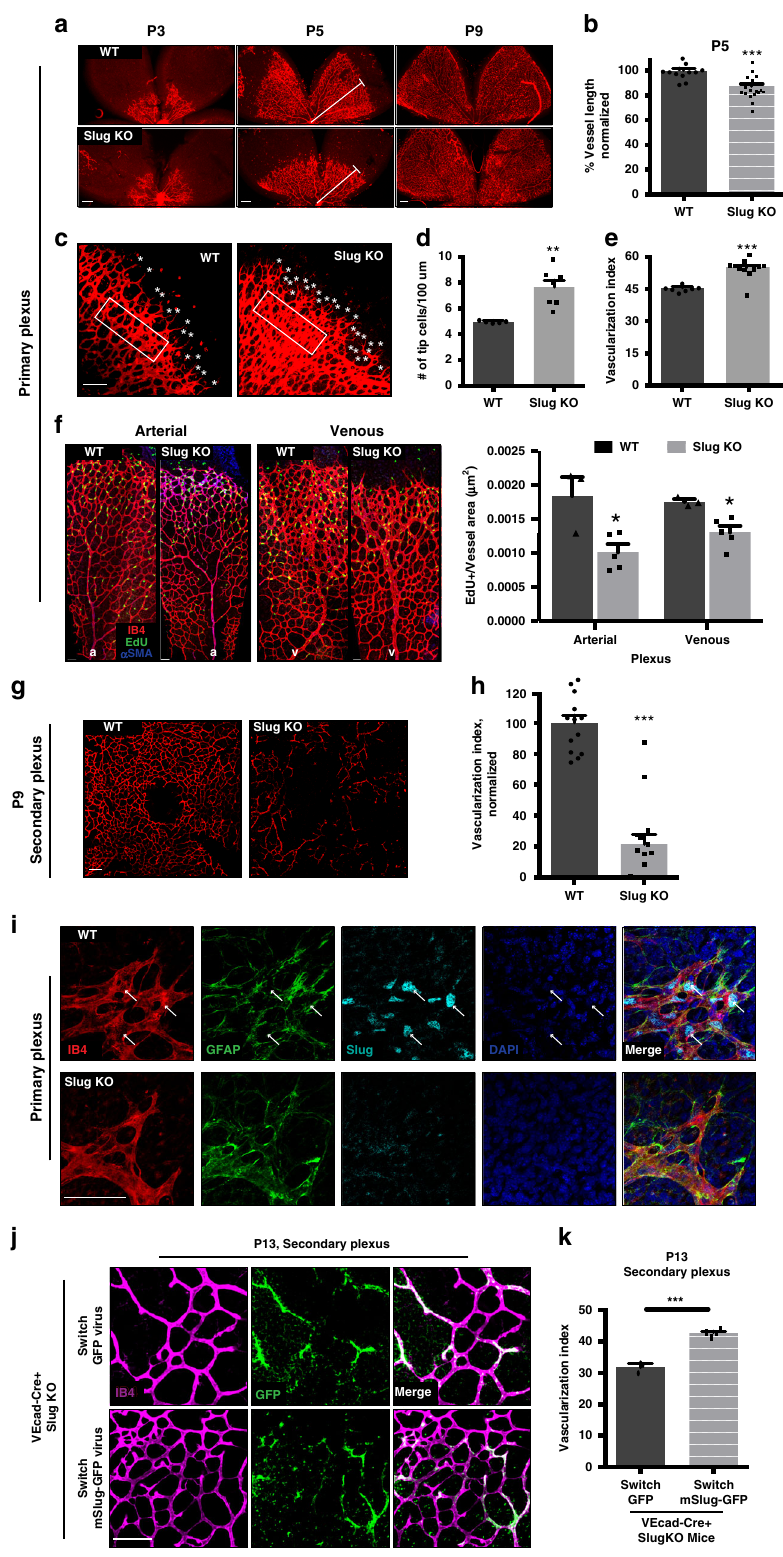
human EC migration in vitro 19 . In SlugKO mice, however, this defect was transient, and became less obvious by postnatal day 9 (P9; Fig. 2a and Supplementary Fig. 4a). Further examination of P5 SlugKO retinas revealed an increase in both tip cell number (Fig. 2c, d) and vessel density, quanti fi ed as vascularization